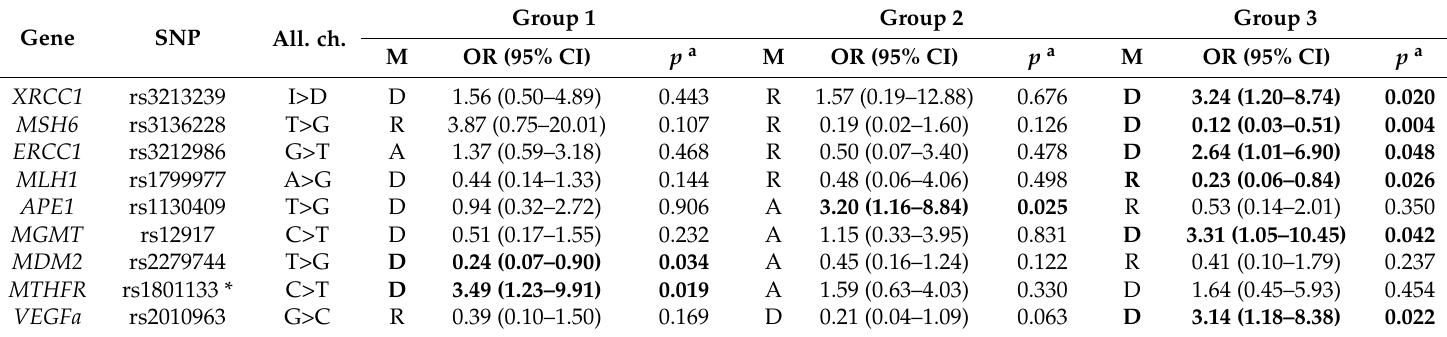
Table 2. Odds ratios (OR) and 95% confidence interval (95% CI) for Tumor Regression Grade (TRG) 2–5 vs. TRG 1 in rectal cancer, according to gene polymorphism and treatment. All patients were treated with fluoropyrimidines-based chemoradiotherapy (CRT). Only single nucleotide polymorphisms (SNPs) resulted significant in at least one subgroup are reported. Statistically significant associations are in bold. Group 1: 94 patients treated with oxaliplatin, fluoropyrimidines, standard dose of radiotherapy (RT) (5040 cGy); Group 2: 73 patients treated with fluoropyrimidines and high dosage of RT (5500 cGy); Group 3: 113 patients treated with fluoropyrimidines and standard dose of RT (5040 cGy). All. ch.: allelic change; M: genetic model; R: recessive; A: additive; D: dominant.